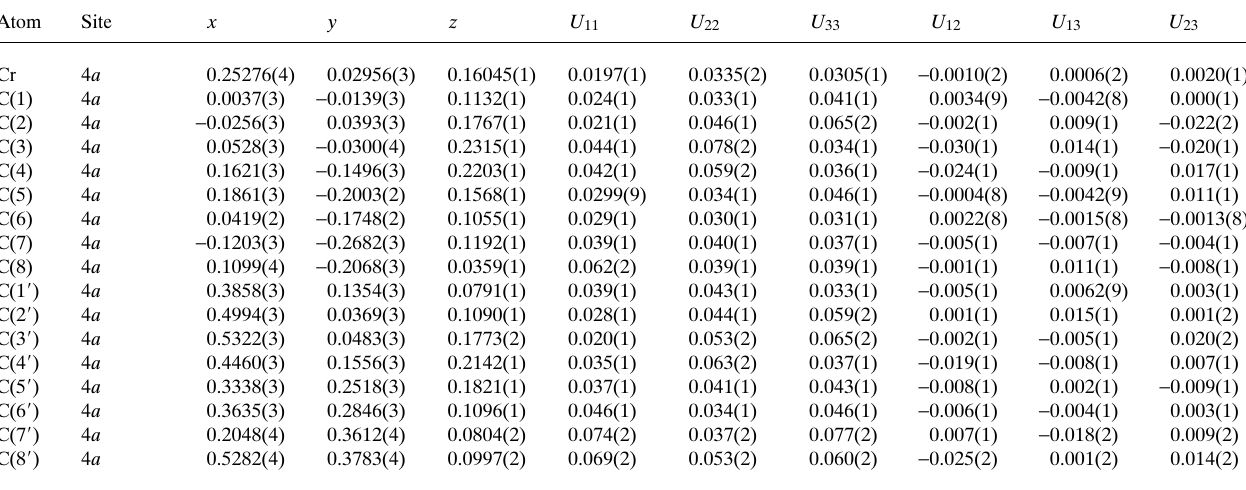
Table 3. Atomic coordinates and displacement parameters (in Å 2 )